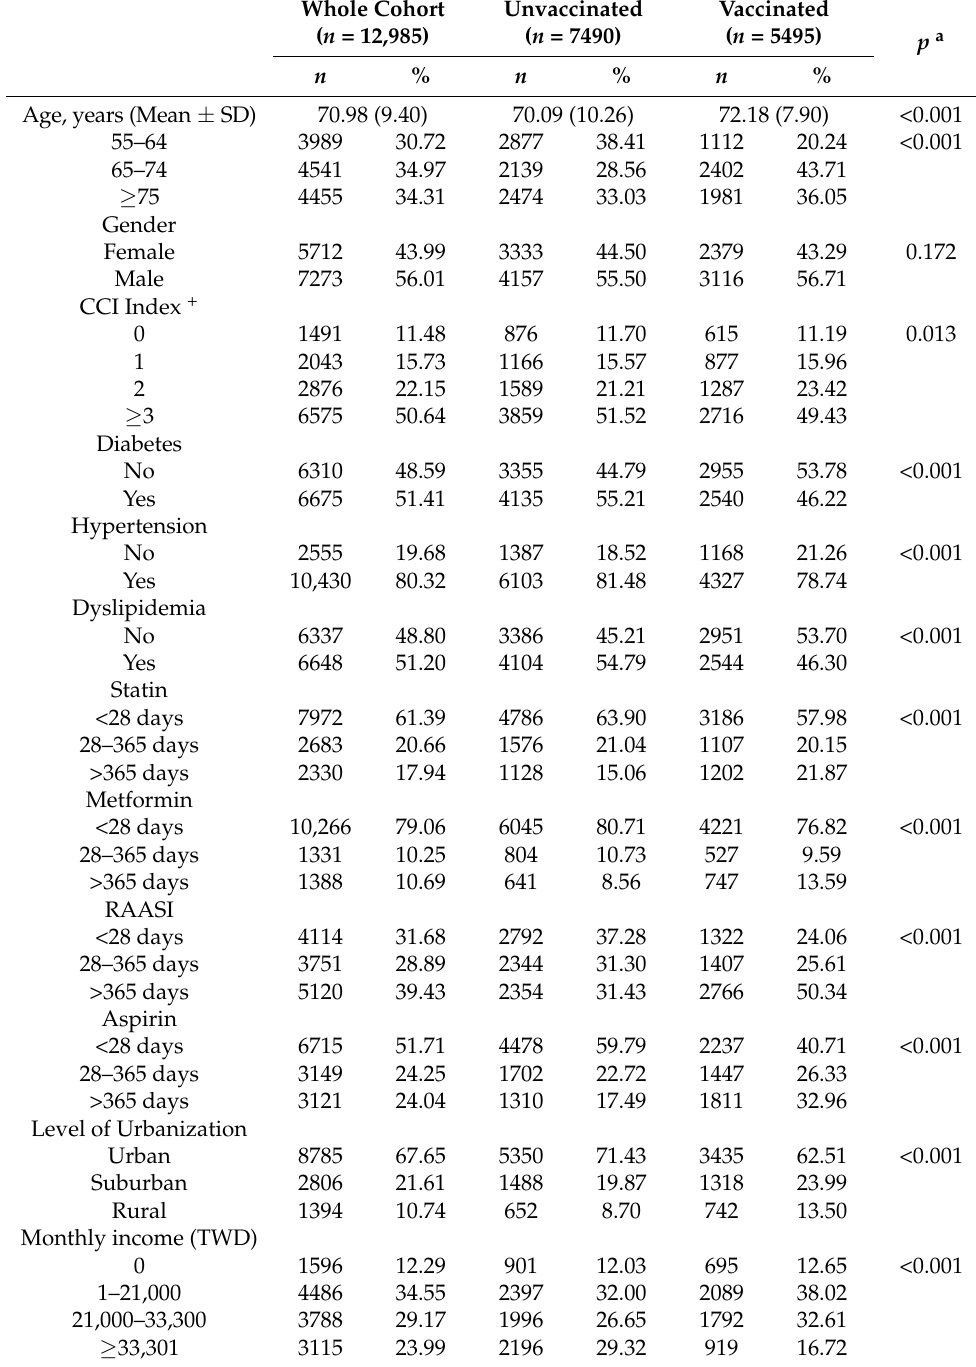
Table 1. Characteristics of the sample